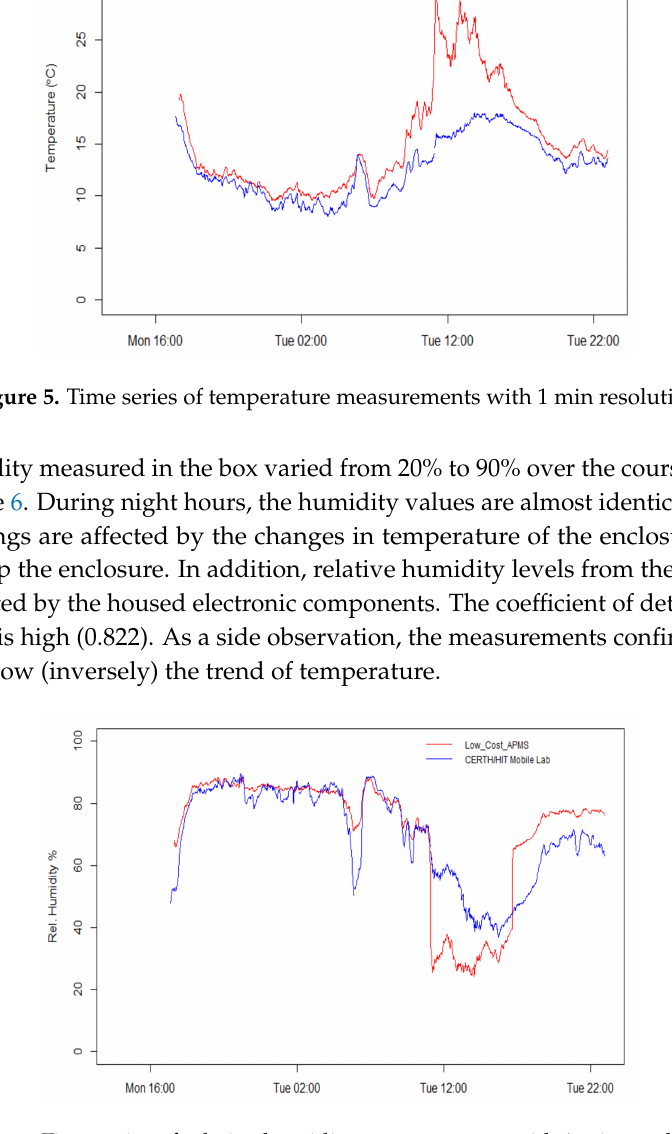
Figure 6. Time series of relative humidity measurements with 1 min